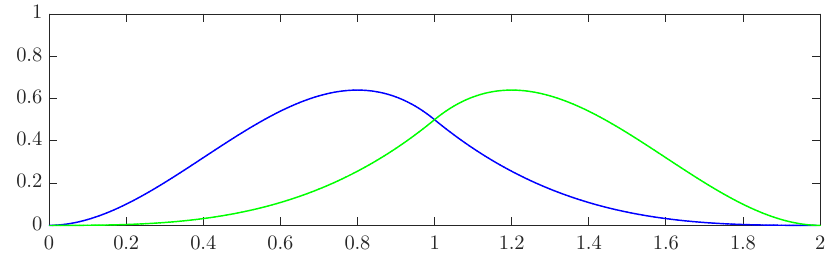
Figure 3. Reference B-splines β 1, [ p , k ] , β 2, [ p , k ] for p = 3 and k =